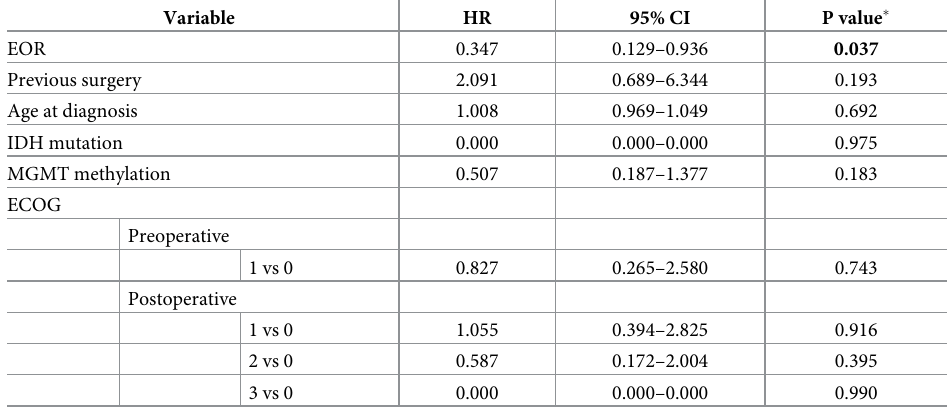
Table 4. Multivariate analysis comparing established prognostic biomarkers from the literature to variables iden- tified as significant in the multivariate analysis, utilising a forward selection strategy for